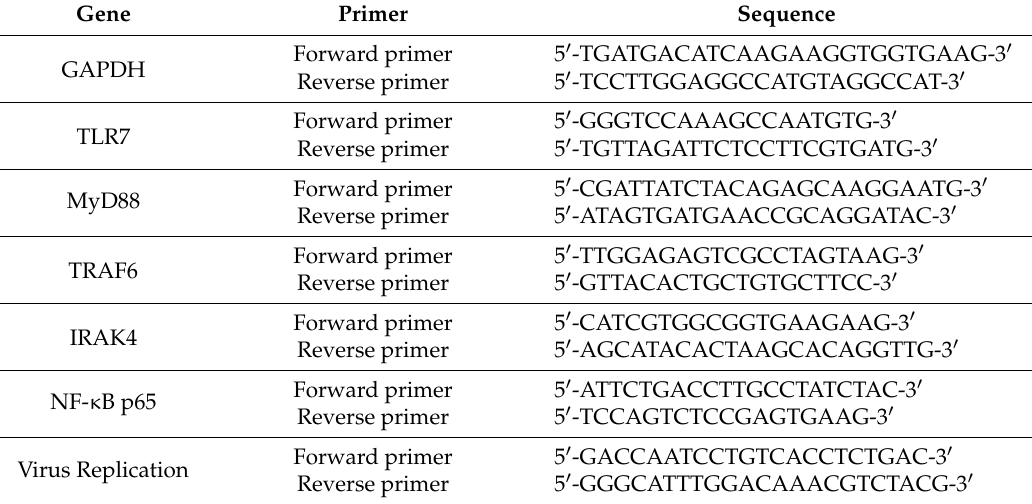
Table 1. Primers used for RT-qPCR